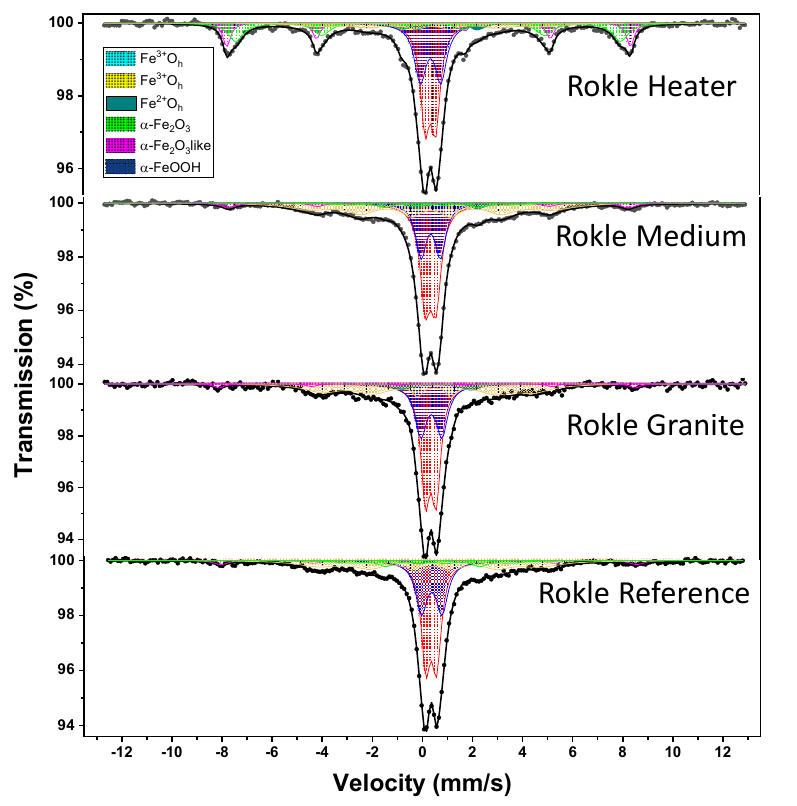
Figure 10. XPS narrow scan Fe 2p and O 1s spectra recorded from the Rokle samples: reference, 4H: close to heater interface, 5M: middle, and 6G: close to granite interface; i.e., at 1.67 cm, 5.00 cm and 8.33 cm from the heater contact, respectively.